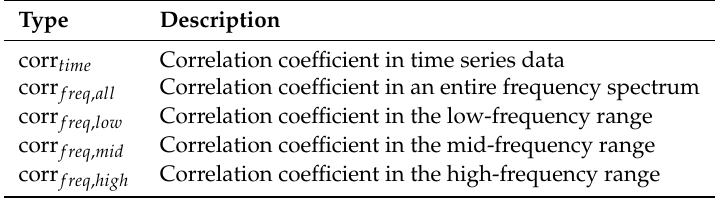
Table 4. Classification features based on correlation coefficients between two